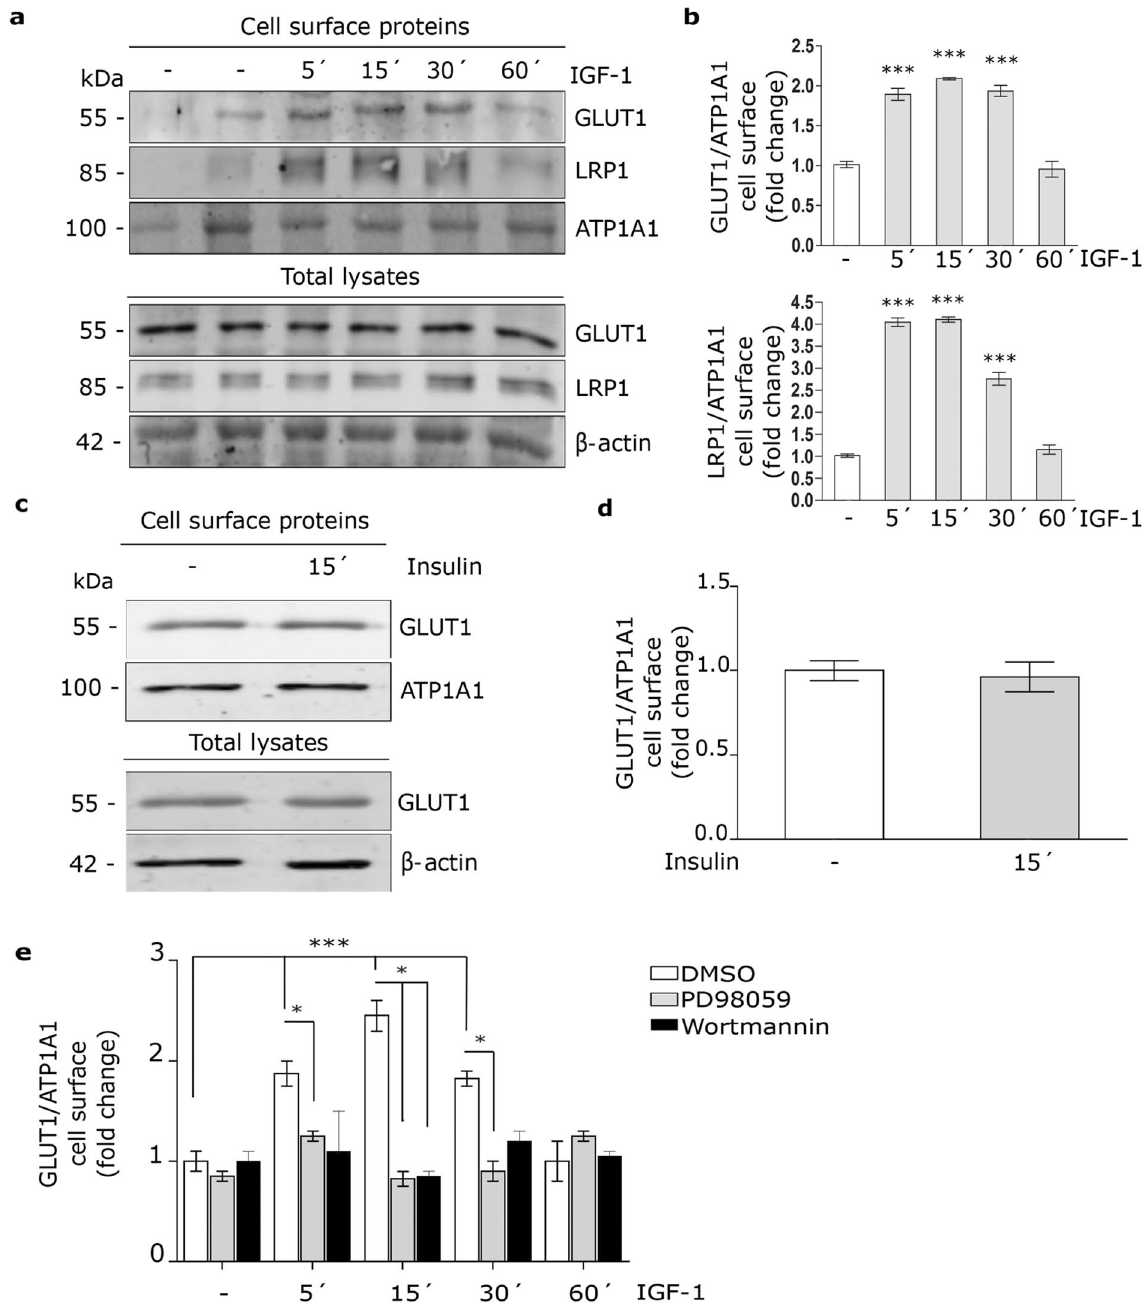
Figure 2. IGF-1 induces GLUT1 traffic to the PM by MAPK/ERK and PI 3 K/Akt signaling activation. ( a ) Biotin-labeling protein assay to measure the expression of GLUT1 and LRP1 in the PM of MIO-M1 cells stimulated with IGF-1 10 nM for 5–60 min. Biotin-labeled proteins were isolated with streptavidin-conjugated beads and then analyzed by Western blot. ATP1A1 and β-actin were used as protein loading controls. Line 1: control without biotin. ( b ) Densitometric quantification of Western blot data for cell surface GLUT1 and LRP1 related to ATP1A1 expressed as fold change respect to non-stimulated control (white bar). Values are expressed as mean ± SEM. *** p < 0.001 versus non-stimulated control. Three independent experiments in duplicate were performed (n = 6). ( c ) Biotin-labeling protein assay to measure expression of GLUT1 in the PM of cells stimulated with Insulin 10 nM for 15 min. Biotin-labeled proteins were isolated with streptavidin-conjugated beads and then analyzed by Western blot. ATP1A1 and β-actin were used as protein loading controls. ( d ) Densitometric quantification of Western blot data for surface GLUT1 related to ATP1A1 expressed as fold change respect to non-stimulated control (white bar). Values are expressed as mean ± SEM. Three independent experiments in duplicate were performed (n = 6). ( e ) Cell surface protein detection assay to measure plasma membrane GLUT1 in cells pretreated with PD98059 (40 μM) or Wortmannin (40 μM) for 30 min and then stimulated with IGF-1 10 nM for 5–60 min. The cell surface level of GLUT1 was analyzed in non-permeabilized cells using anti-GLUT1 antibody as is indicated in detail in Methods. Values are expressed as mean ± SEM. *** p < 0.001 versus non-stimulated control. * p < 0.05 versus indicated conditions. Three independent experiments in duplicate were performed (n =